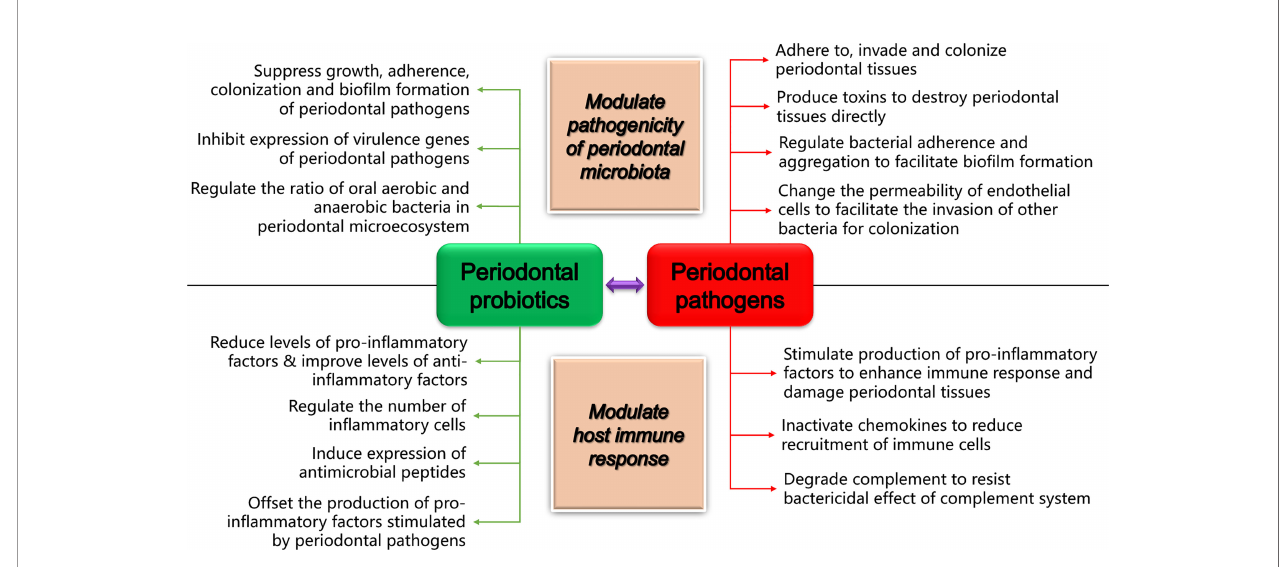
FIGURE 1 | How periodontal probiotics and pathogens play their roles in regulating periodontal health and disease. The diagram shows the primary mechanisms of periodontopathogens and probiotics in regulating periodontal microbiota and host immune responses,